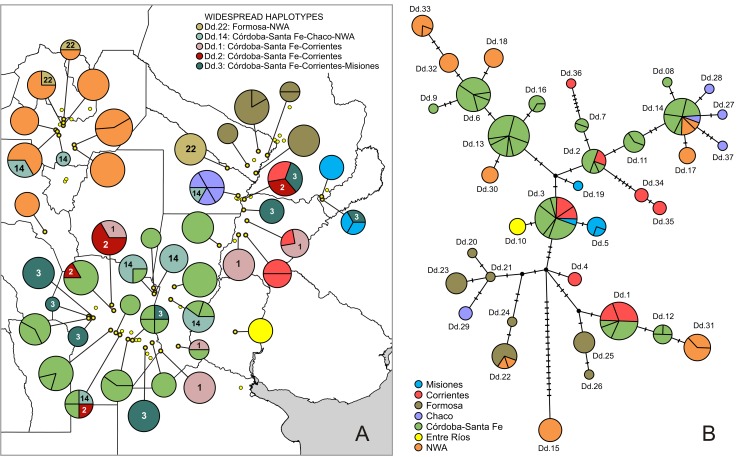
Haplotypes of Discocyrtus dilatatus: Distribution and network.(A) Geographical distribution of haplotypes. Circles sizes are proportional to the number of specimens examined in each locality; its internal divisions represent the number of haplotypes per locality. Dots indicate known records of D. dilatatus; those with thick outline are the localities studied in the phylogeographic analysis. Widespread haplotypes (i.e., shared by two or more sectors of the species range) are identified with a number and the color key in the inset; other haplotypes just use the color standardized in the inset of B. Map was designed using free spatial data available at http://www.diva-gis.org/Data. (B) Median-joining haplotype network. The number of mutational steps between adjacent haplotypes is represented by line marks. The size of circles corresponds to the frequency of each haplotype, and the number of localities where a given haplotype occurs is displayed as internal divisions. Colors indicate the geographical sectors recognized in the species range, as defined in the inset and in Table 1.